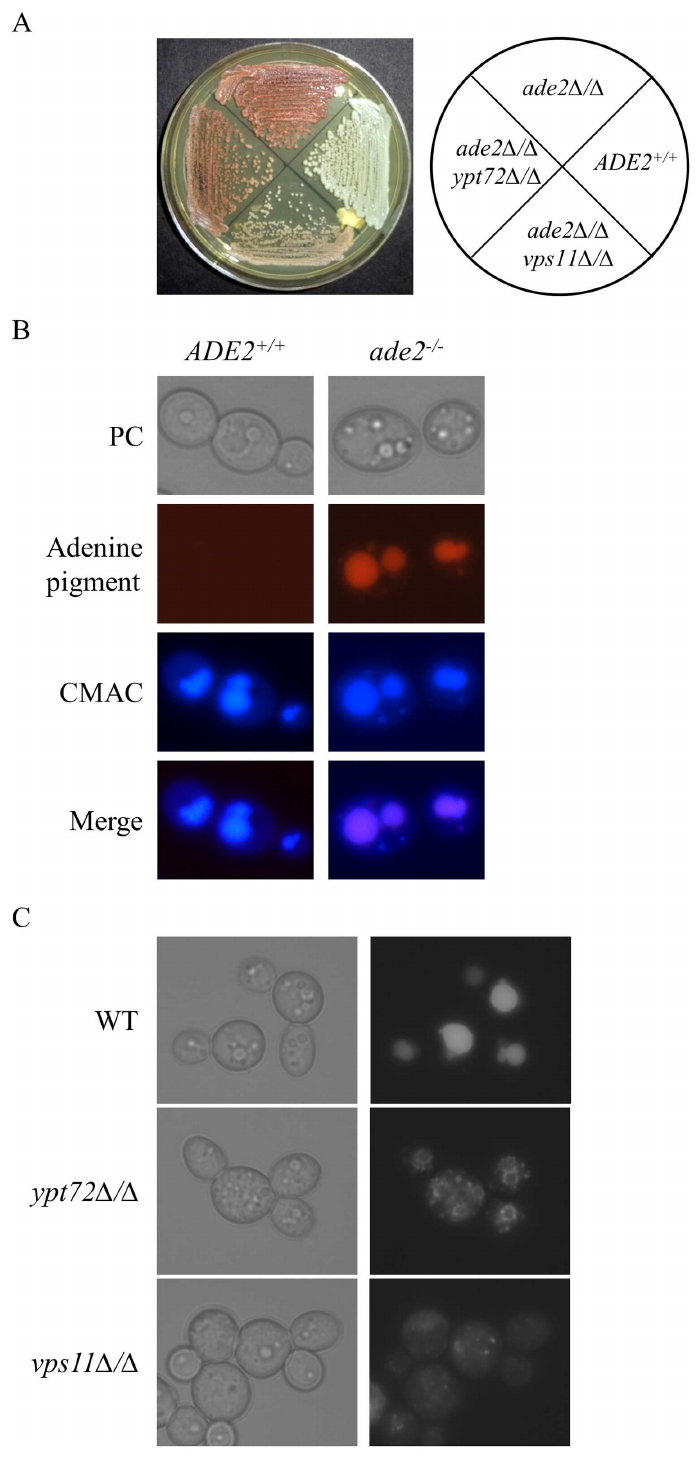
Fig 1. C. albicans ade2 mutant produces a fluorescent pigment that localizes within the fungal vacuole. (A) ADE2 +/+ (SC5314), ade2 -/- (CAI8LUX1), ade2 -/- ypt72 Δ / Δ (C8ypt72 Δ / Δ ) and ade2 -/- vps11 Δ / Δ (C8vps11 Δ / Δ ) mutant strains were streaked to YPD agar and incubatedfor 48 hours prior to imaging. (B) ADE2 +/+ and ade2 - /- strains were grown in YNB + 5 μ g/ml adenineovernight, stained with CMAC and examinedby fluorescentmicroscopy using TRIT-C and DAPI filter sets. (C) ade2 -/- (WT), ade2 -/- ypt72 Δ / Δ